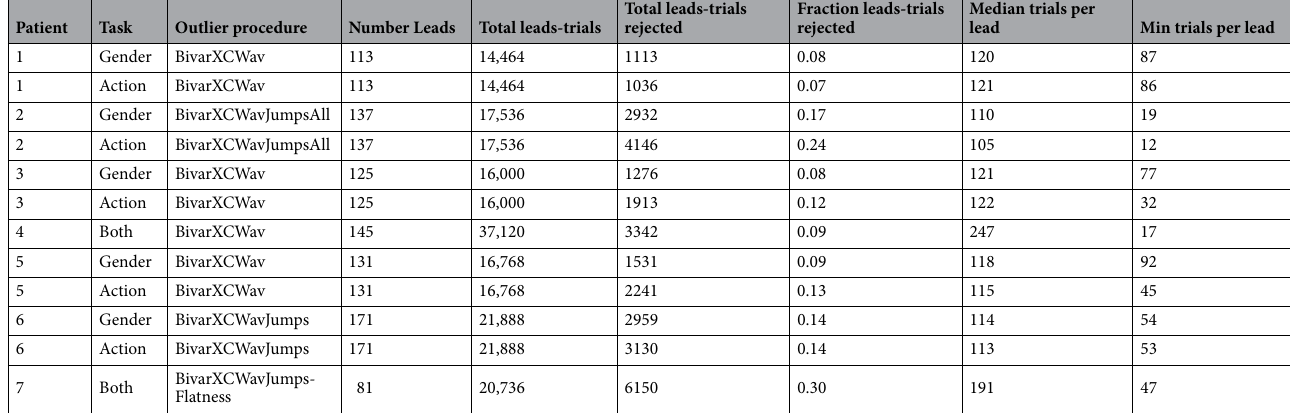
Table 2. Global performance of artefact rejection for Granger Causality